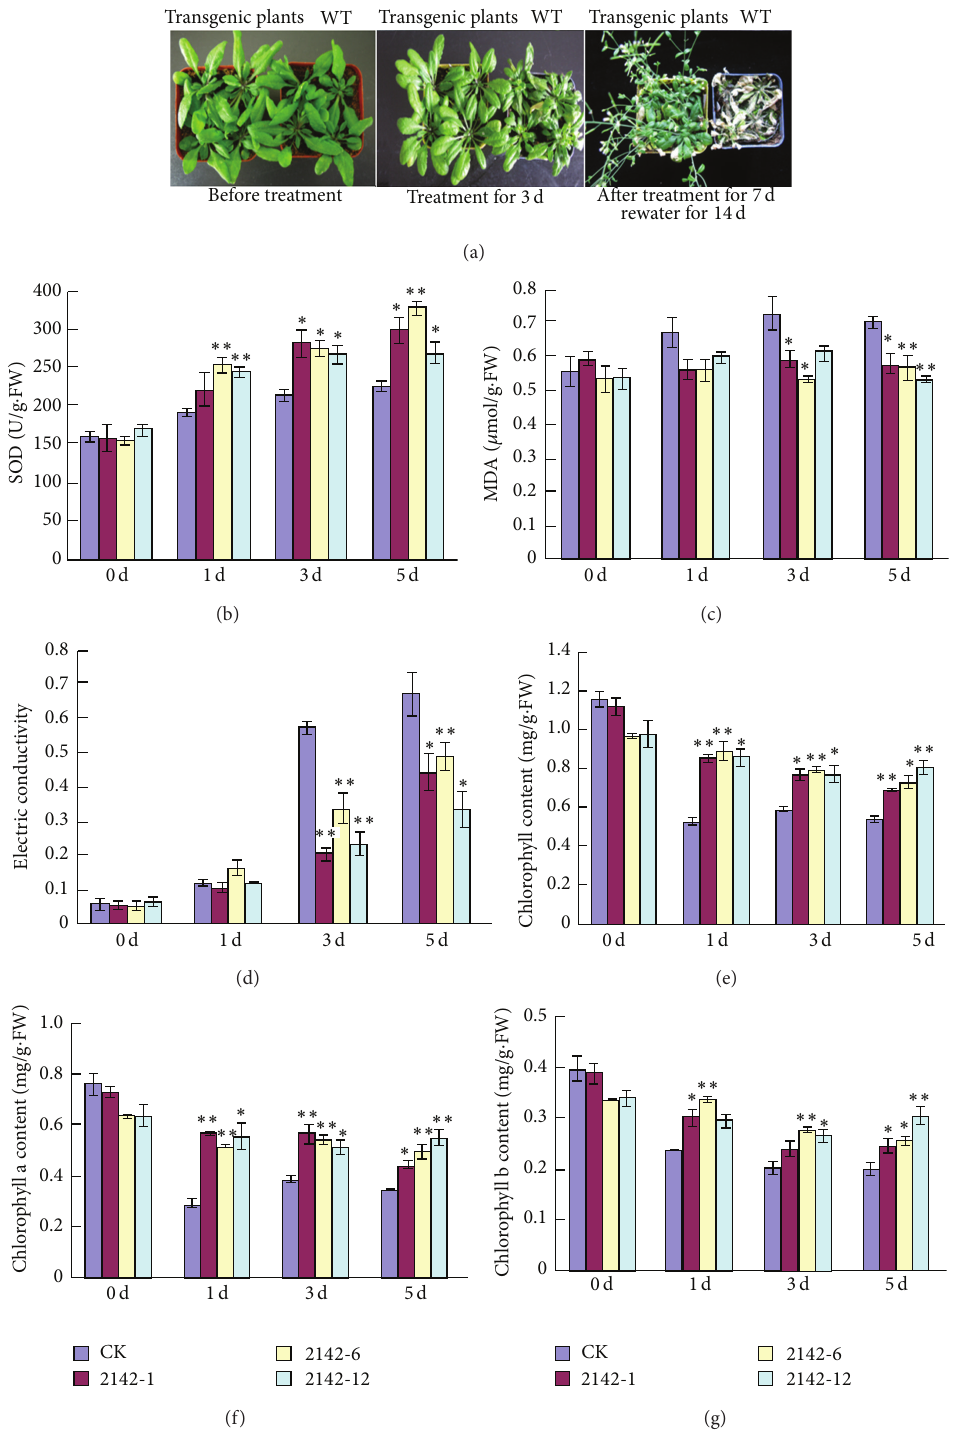
Figure 4: Physiological comparison of control and CCHA-2142 -overexpressing Arabidopsis thaliana . (a) Salt tolerance of transgenic plants and WT. Delayed senescence was observed for the transgenic line as compared with WT upon stress with 200 mM NaCl for 3d. Comparison of SOD activity (b), malondialdehyde (MDA) content (c) and electrical conductivity (d), total chlorophyll content (e), chlorophyll 𝑎 content (f), and chlorophyll 𝑏 content (g) between CCHA-2142 -transformed and wild-type Arabidopsis thaliana plants under 200 mM NaCl stress for 1d, 3d, and 5 d. 0 d: without stress. Lane CK: negative control (wild-type Arabidopsis thaliana ); Lines 2142-1, 2142-6, and 2142-12: transgenic Arabidopsis thaliana lines. Data represent means ± standard deviations (SD) of three biological replicates. One asterisk and two asterisks indicate significant differences at 𝑃 ≤ 0.05 and 𝑃 ≤ 0.01 compared with WT by Student’s 𝑡 -test,